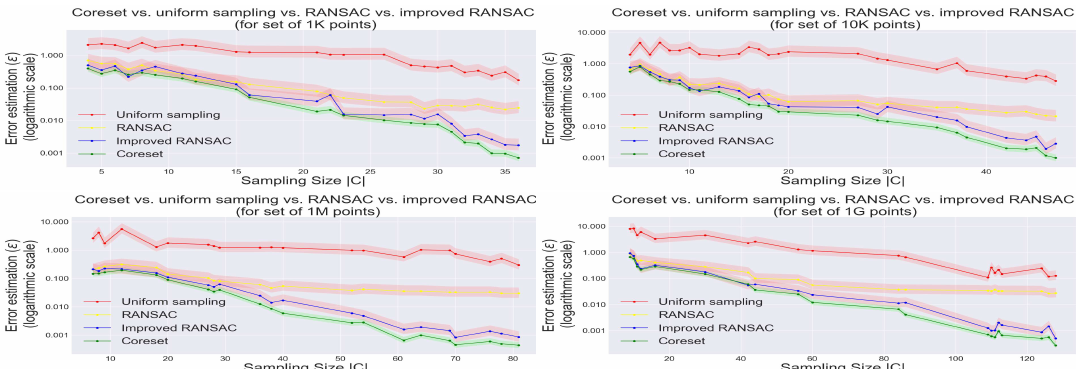
Figure 4. The 2D experiments result. The following four graphs show comparison results between coreset sampling by our algorithm with uniform sampling and the same amount of sample data, compared to the RANSAC algorithm (on the full set and on the coreset) that runs at the same time. Each graph displays results for a differently-sized data set.